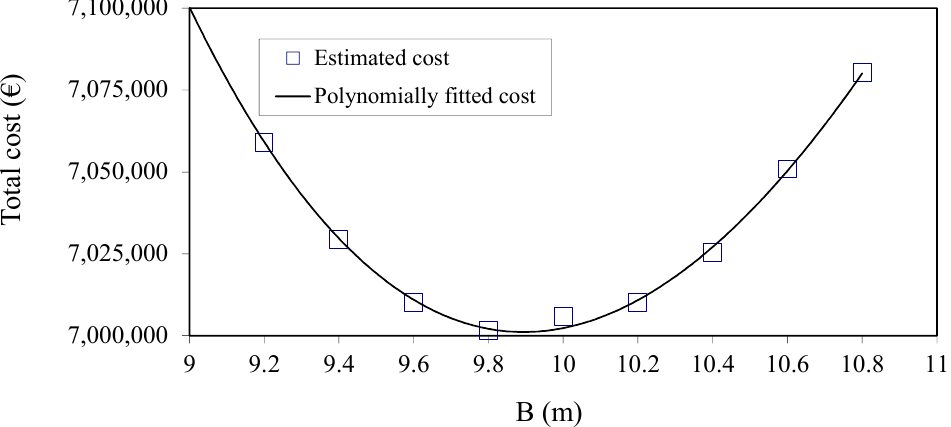
Figure 13. Total costs (€) as a function of the berm width, B (m), for h berm = 1 m.